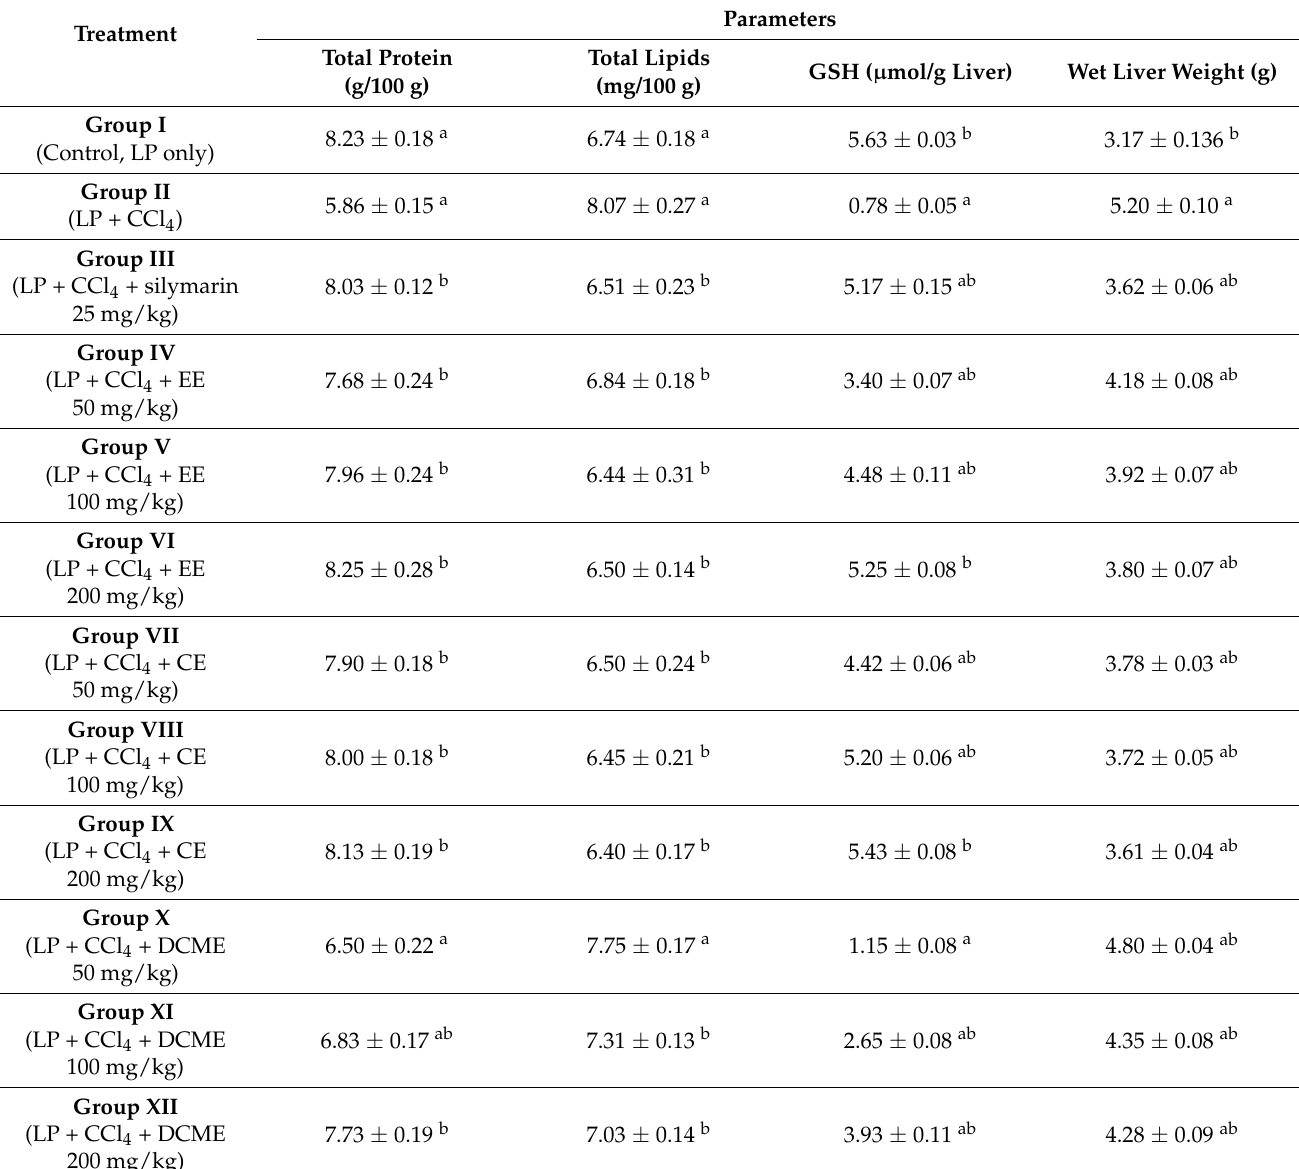
Table 12. Effect of EE, CE and DCME of N. triquetra on biochemical parameters in liver.